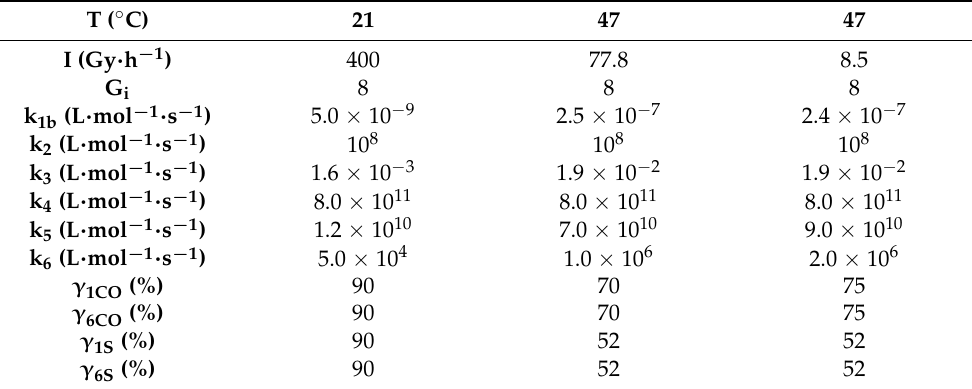
Table A1. Values of parameters used for modeling the oxidation kinetics of the unfilled Si-XLPE matrix in the various radio-thermal environments under study